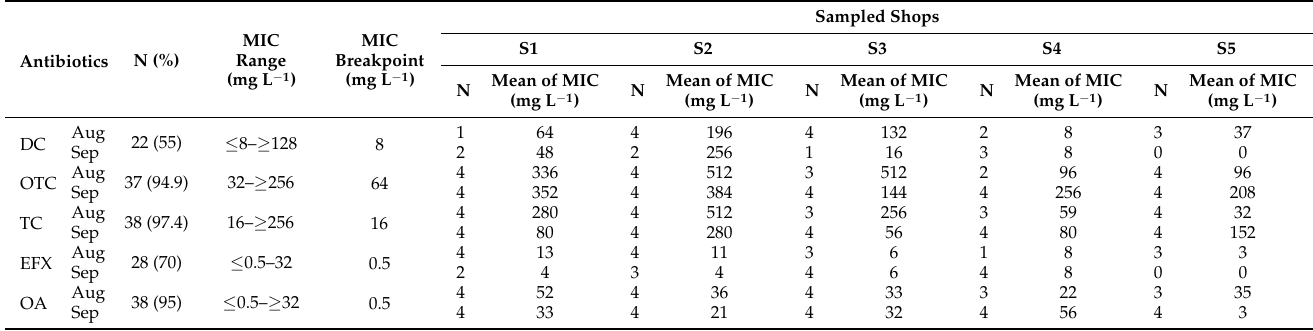
Table 2. Antibiotic resistance prevalence and levels of Aeromonas spp.